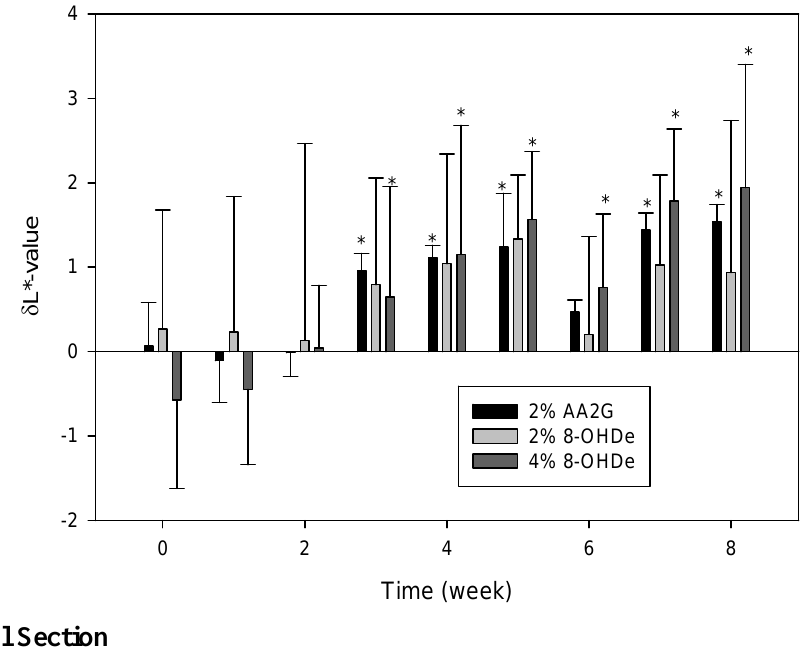
Figure 3. Time course versus  L*-values of different drug treatments. The  L*-value of a drug treatment was calculated from the difference between the mean L*-value of drug-treated volunteers and that of placebo-treated volunteers every week. Bars represent means ± S.D. of data from the total number of volunteers in the tested